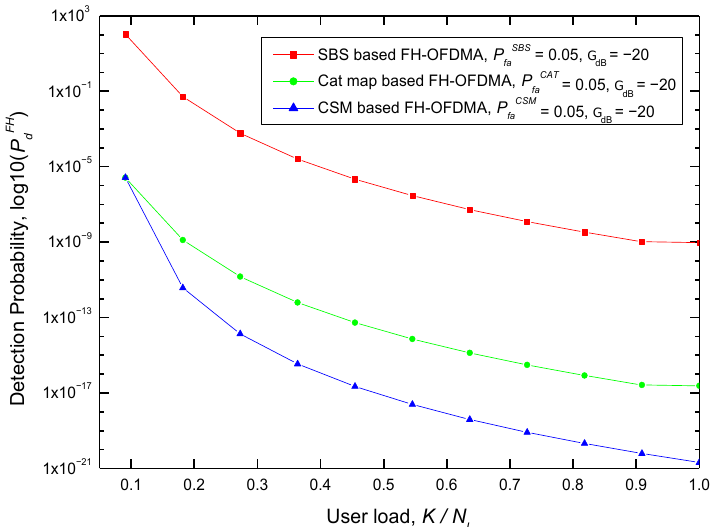
Figure 7. Detection probability versus user load compared to SBS, cat map, and CSM-based FH patterns.